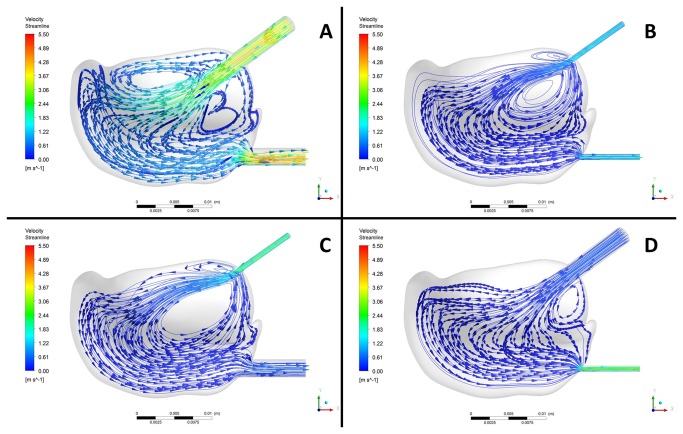
Fluid velocity contours in the upper compartment of a TMJ during a lavage process.The lavage process was conducted with (A) KK, (B) NN, (C) NK and (D) KN type needles. “N” and “K” represent the needle of smaller and bigger diameter, respectively. In acronyms, the former letter represents the inflow needle, and the later one indicates the outflow needle.